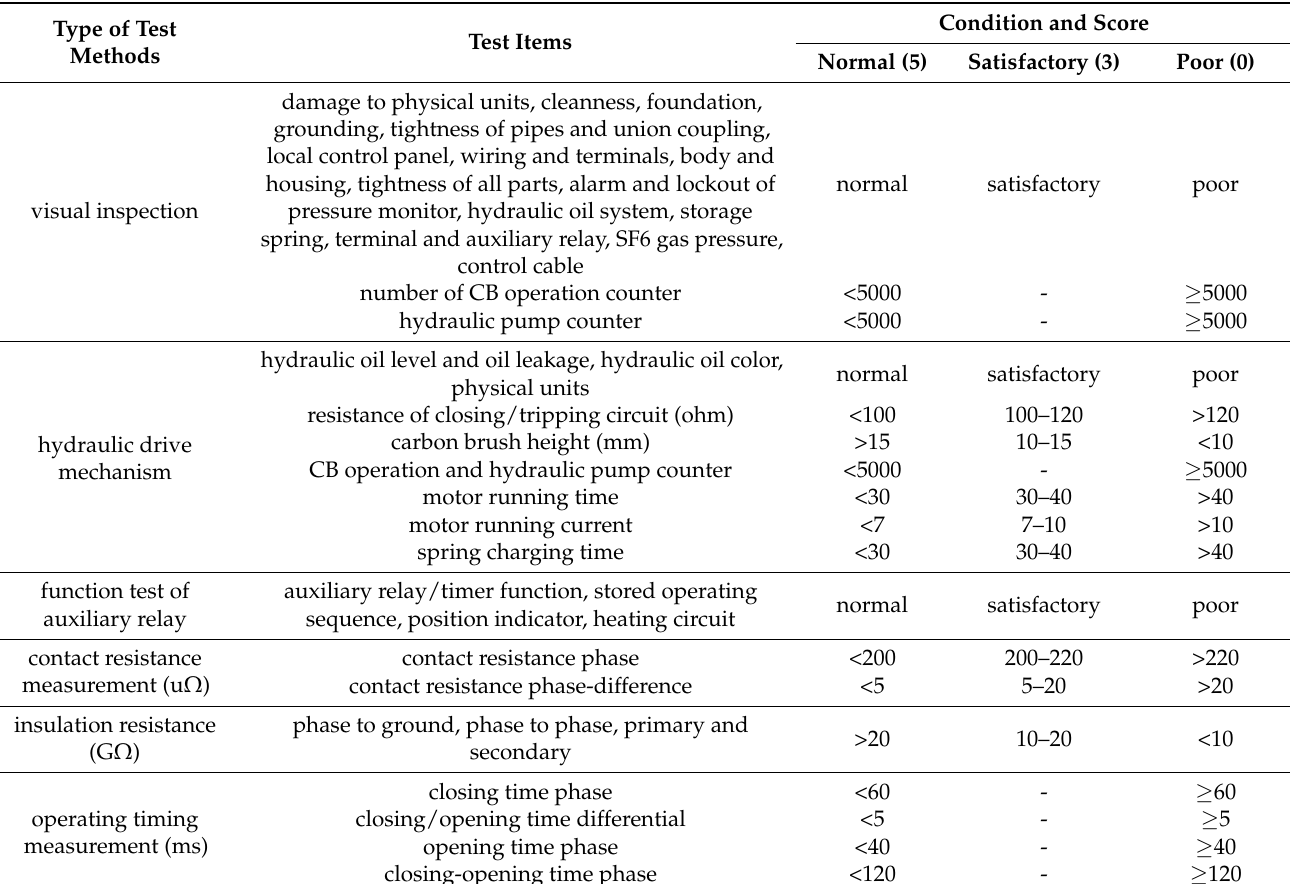
Table 3. CB testing methods and visual inspection.